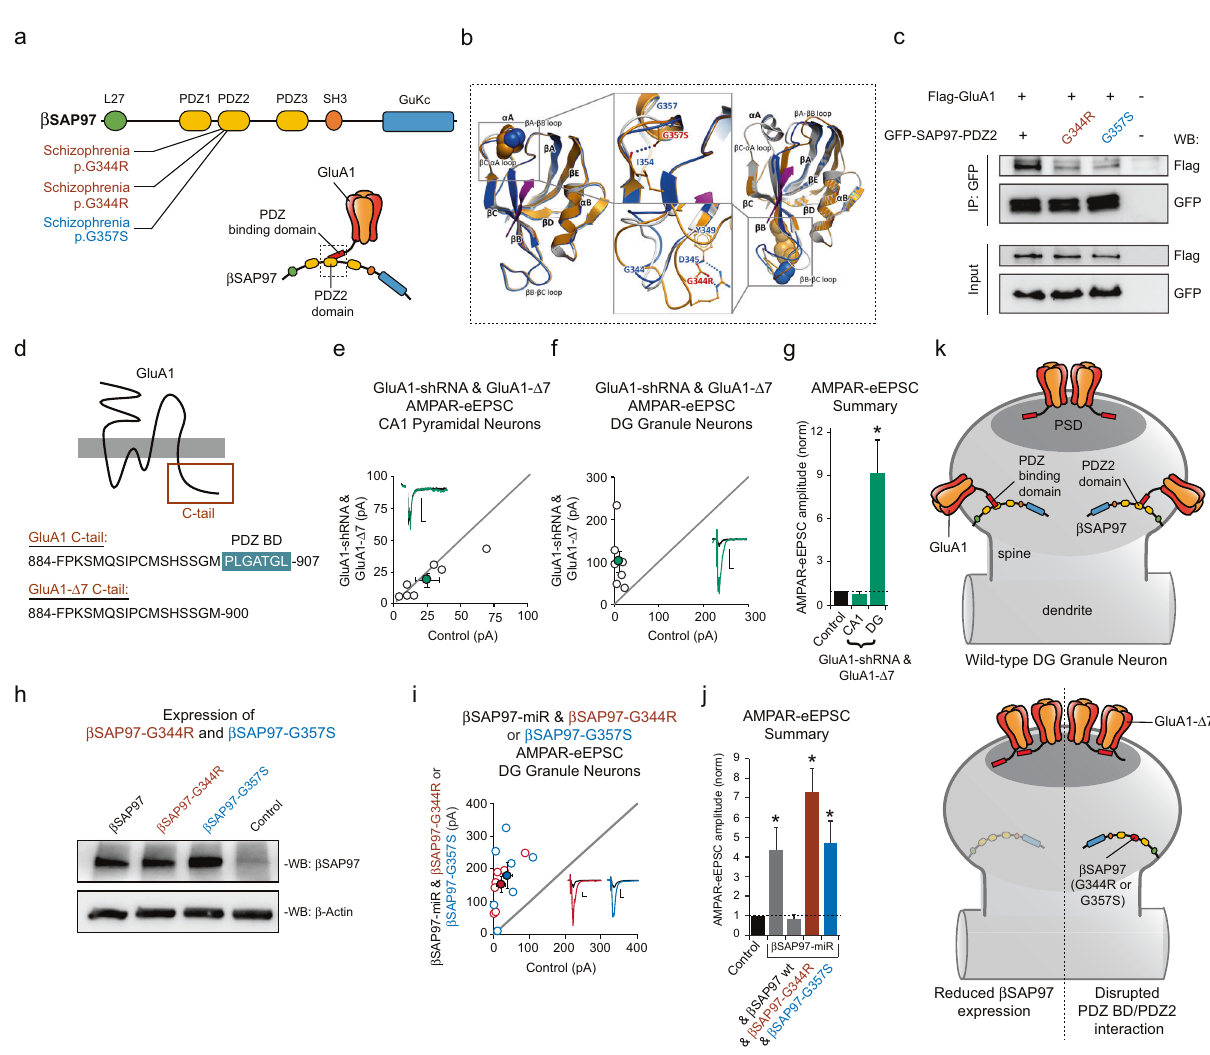
Fig. 5 Clustered schizophrenia-related missense mutations in β SAP97 ’ s PDZ2 domain release GluA1-containing AMPARs into perforant pathway synapses. a Illustration of β SAP97 ’ s protein domain structure and location of schizophrenia-related missense mutations identi fi ed in SAP97 (Top). Illustration of interaction between GluA1 ’ s PDZ-binding domain and β SAP97 ’ s PDZ2 domain (Bottom, dashed box). b Protein structural modeling of schizophrenia-related mutations in β SAP97 ’ s PDZ2 domain predict disruption of PDZ2 ’ s interaction with GluA1 ’ s PDZ-binding domain (see Supplementary Fig. 5 for more details). c Co-immunoprecipitation of FLAG-GluA1 with GFP-SAP97-PDZ2, GFP-SAP97-PDZ2(G344R), or GFP-SAP97-PDZ2(G357S) in HEK293T cells. See methods for details. Quanti fi cation for n = 3 independent experiments provided in Supplementary Fig. 6a. d Topology of the AMPAR subunit GluA1 and C-terminal amino acid sequences for GluA1 and GluA1- Δ 7. GluA1 ’ s PDZ-binding domain (PDZ BD) is highlighted in blue. For panels ( e ), ( f ), and ( i ), open circles in the scatter plots represent single pairs of control and transfected neurons, fi lled circles represent the mean amplitudes (±SEM), insets show representative current traces from control (black) and transfected (in color) neurons with stimulation artifacts removed. Scale bars: 20 ms, 20 pA. e Molecular replacement by co-expression of the GluA1-shRNA and GluA1- Δ 7 has no effect on AMPAR-eEPSCs in CA1 pyramidal neurons ( n = 7 pairs, p = 0.16, paired T test). f Molecular replacement by co-expression of GluA1-shRNA and GluA1- Δ 7 signi fi cantly increases AMPAR-eEPSC amplitude in DG granule neurons ( n = 7 pairs, p = 0.016, paired T test). g Summary bar graph for ( e ) and ( f ) shows the average AMPAR-eEPSC amplitudes (±SEM) of CA1 pyramidal neurons and DG granule neurons with co-expression of GluA1-shRNA and GluA1- Δ 7 normalized to their respective control neurons. h Representative western blot analysis showing that β SAP97-G344R and β SAP97-G357S exhibit levels of expression in HEK293 cells similar to that of wild- type β SAP97 ( n = 2 independent experiments). i Molecular replacement of β SAP97 with β SAP97-G344R and β SAP97-G357S in DG granule neurons signi fi cantly increases AMPAR-eEPSC amplitude ( β SAP97-G344R, n = 7 pairs, p = 0.0004, paired T test; β SAP97-G357S, n = 7 pairs, p = 0.01, paired T test). j Summary bar graph shows the average AMPAR-eEPSC amplitudes (±SEM) of the conditions compared in panel ( i ). * p < 0.05. k Model of β SAP97- mediated regulation of glutamatergic synaptic function. GluA1-containing AMPARs on the surface of neurons are held perisynaptically by an interaction between β SAP97 and GluA1 ’ s PDZ-binding domain. Reducing β SAP97 expression or inhibiting GluA1 ’ s ability to bind to β SAP97 ’ s PDZ2 domain results in local rearrangement of AMPA receptor organization in spines whereby AMPA receptors normally held by β SAP97 perisynaptically are released and then grabbed by PSD-95, PSD-93, and SAP102 in the PSD. All statistical tests performed were two-sided. Source data are provided in the Source Data fi le.